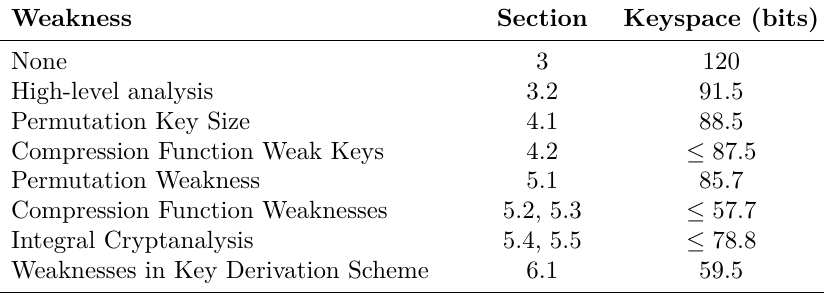
Table 2: How each weakness reduces the claimed key